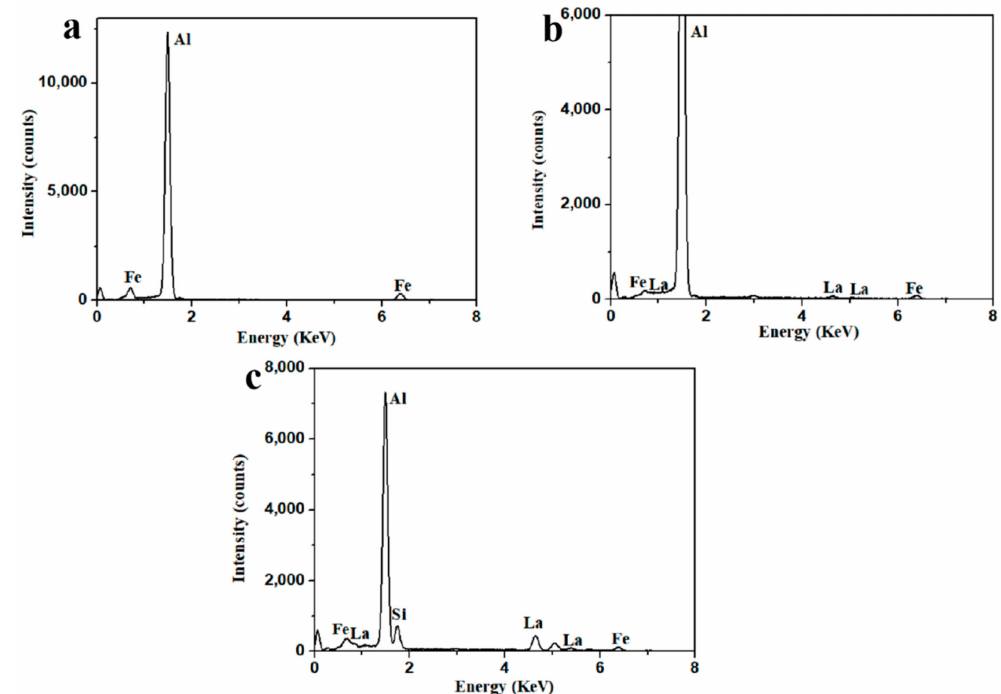
Figure 2. Typical energy dispersive spectroscopy (EDS) analyses of: ( a ) sharp coarse bulk (R) phase; ( b ) fine spherical (S) phase; and ( c ) clustered irregular T phase.